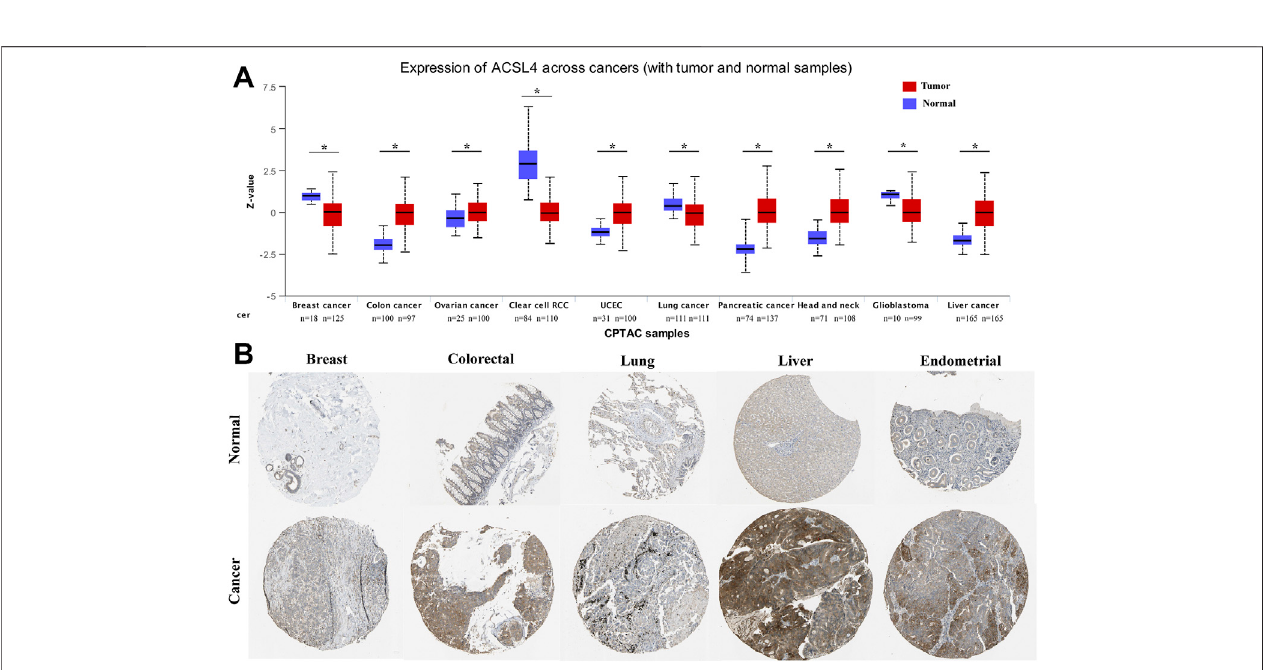
FIGURE 2 | Protein expression levels of ACSL4 in different Cancers. (A) . The protein expression of ACSL4 in six cancers and normal tissues from the UALCAN database (* p < 0.05). Z-values represent standard deviations from the median across samples for the given cancer type. Log2 Spectral count ratio values from CPTAC were fi rstnormalizedwithineachsamplepro fi le,thennormalizedacrosssamples.UCEC(uterinecorpusendometrialcarcinoma). (B) .theproteinexpressionofACSL4in tumors and normal tissues were obtained from the Human Protein Atlas.